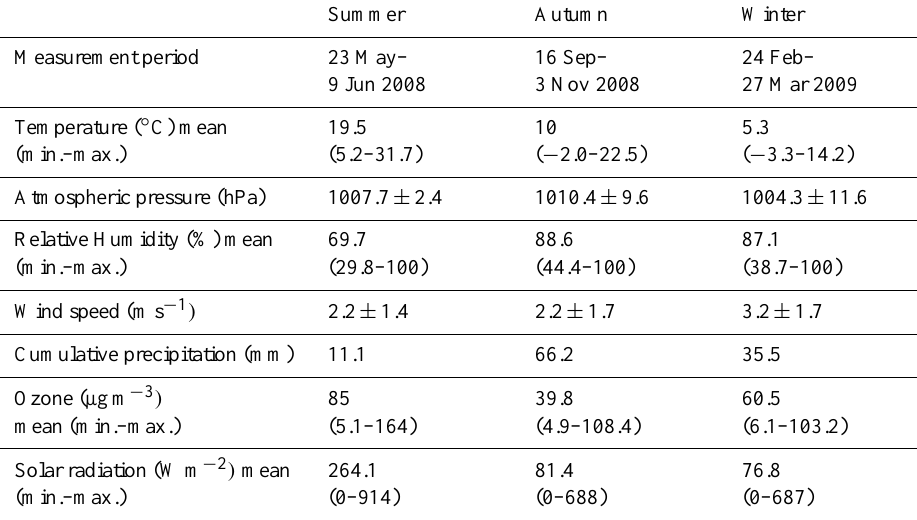
Table 1. Summary of the meteorological conditions for the three measurement